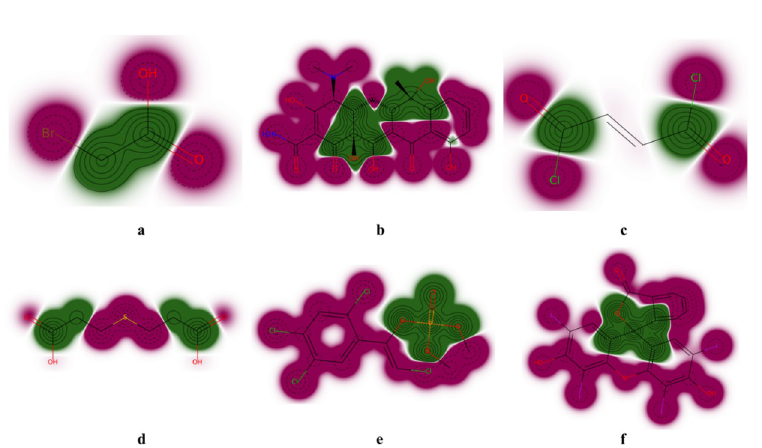
Fig 12. An example diagram showing the correlation between atomic and molecular toxicity using similarity maps. Red represents a higher correlation, and green represents a lower correlation.